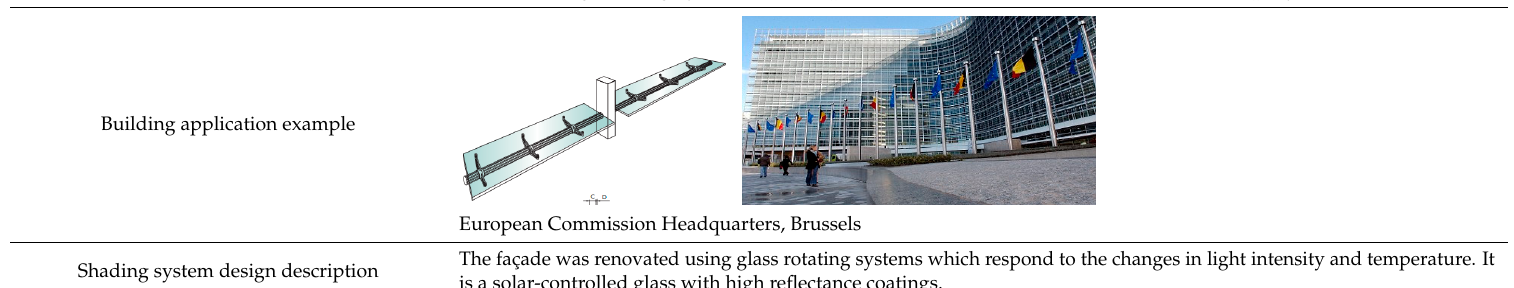
Table 3. Application of materials of external shading systems.